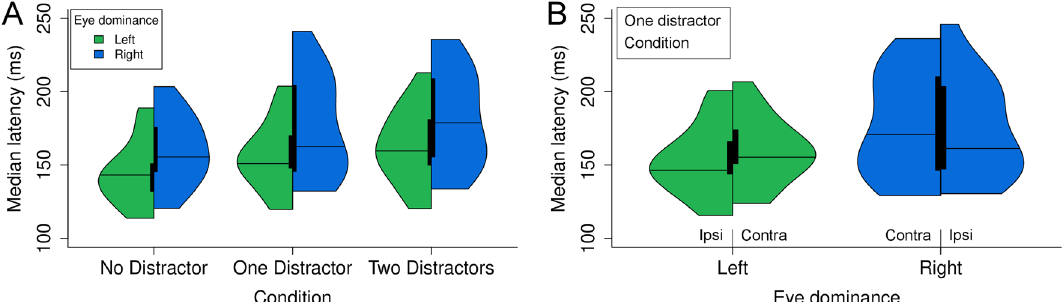
Figure 2. Median latency distributions for both left and right eye dominance participants. ( A ) No Distractor, One Distractor and Two Distractors conditions. Horizontal lines correspond to the median, thick vertical lines show the interquartile range and green and blue area correspond to the kernel latency density estimation (interrupted at minimum and maximum values). For the One Distractor condition, trials with the distractor in the contralateral and the ipsilateral hemifield have been merged. ( B ) One Distractor condition for each participant group. Ipsi and Contra correspond to the hemifield in which the distractor was placed relative to the DE. See text for further